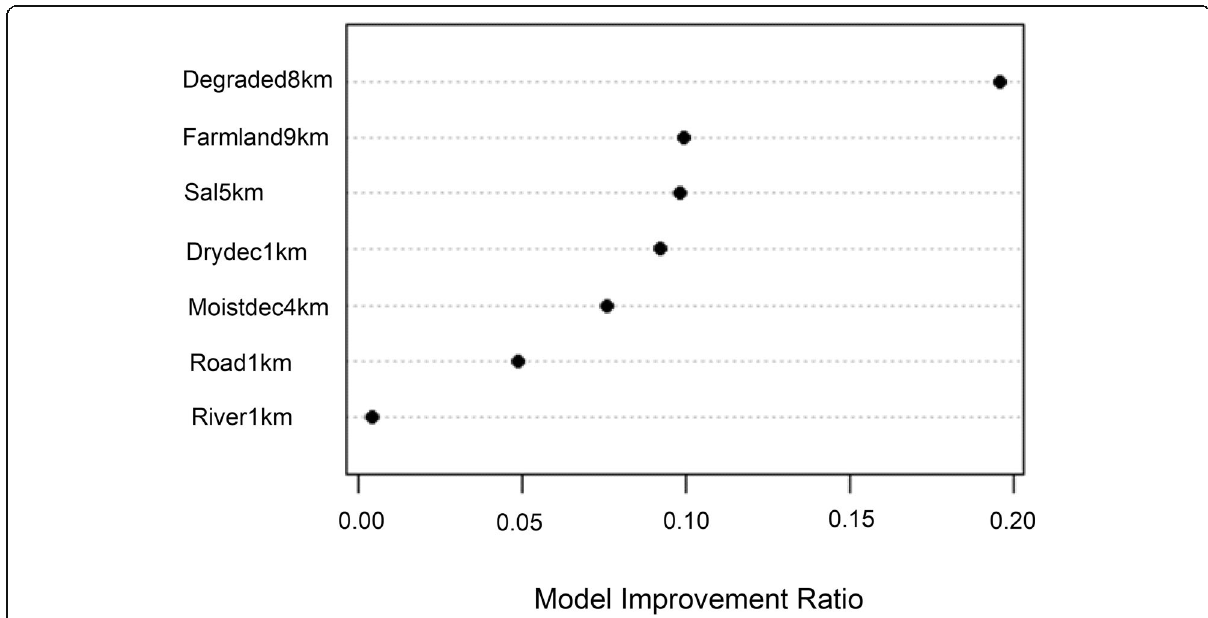
Fig. 3 Variable importance plot for scaled variables used in the multivariate random forest model of sloth bears based on model improvement ratio (MIR). The degraded forest was the most important variable, and the river density was the least important variable. Rest of the variables are listed in order of their relative importance to degraded forests. The X -axis represents the relative additional model improvement with the addition of each successive variable. Variables included are degraded8km, degraded forests; Farmland_9km, farmlands; sal5km, sal-dominated forests; drydec1km, dry deciduous forests; moistdec4km, moist deciduous forests; road1km, road density; and river1km, river density. The numerical value succeeding each variable represents the respective spatial